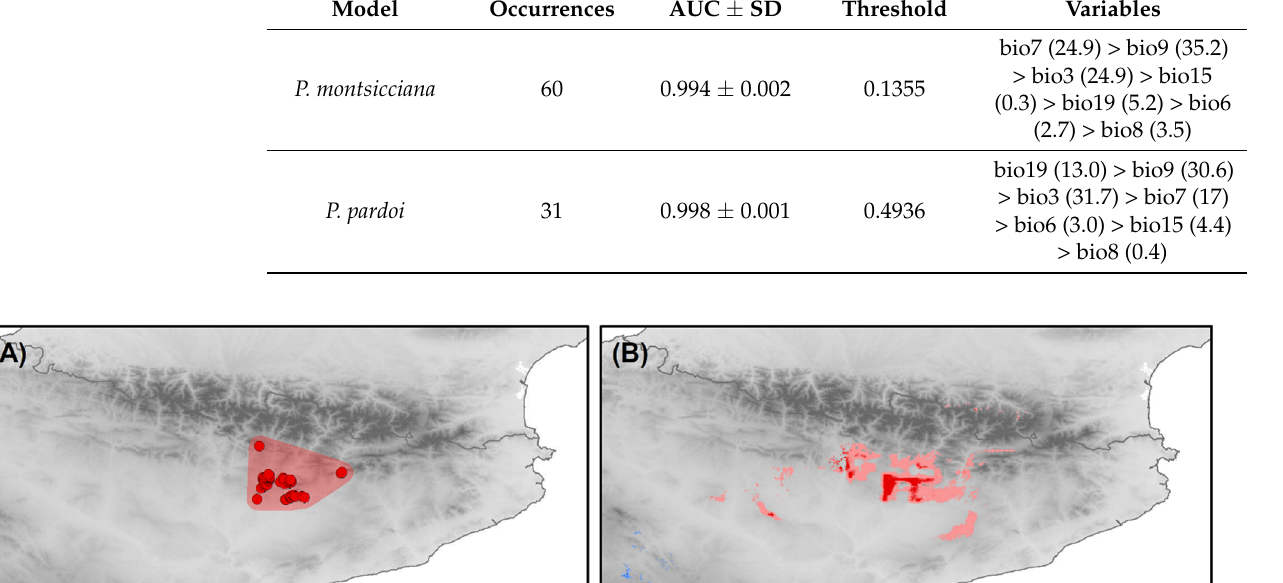
Table 2. Occurrences of Petrocoptis montsicciana and P. pardoi , model performance assessed by the area under the curve (AUC ± standard deviation), threshold values as the maximum training sensitivity plus specificity threshold (MSS), and importance of all variables based on jackknife analyses (in parenthesis the percentage contribution to models).